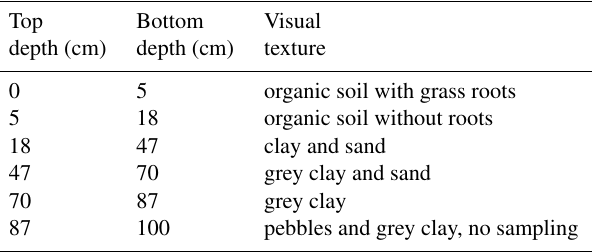
Table 1. Visual characterization of the soil layers corresponding to Fig. 4 on 29 September 2008.